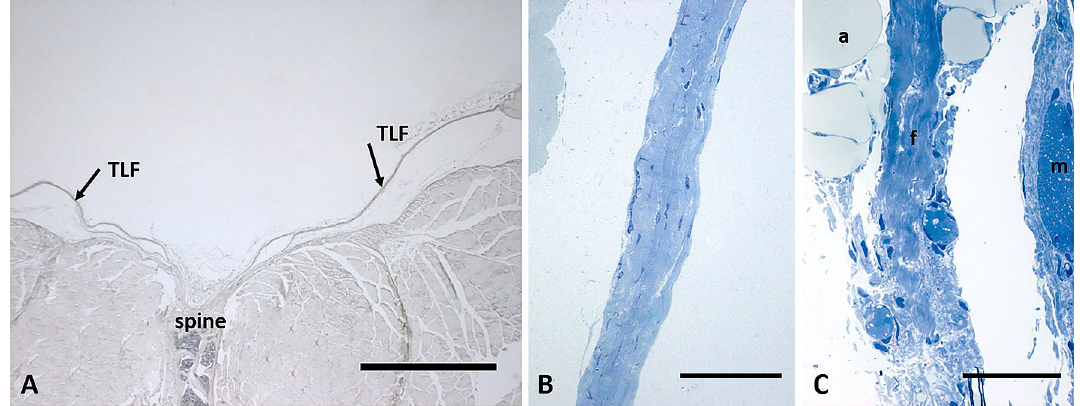
Figure 1. Thickness of thoracolumbar and gluteal fascia: ( A ) 5 µm section of fascia, spine and muscle, stained with ematoxylin and eosin; arrows indicate the thoracolumbar fascia (TLF); scale bar: 1000 µm; ( B ) 0.5 µm semithin section of thoracolumbar fascia stained with Toluidine Blue; scale bar: 50 µm; ( C ) 0.5 µm semithin section of gluteal fascia stained with Toluidine Blue; a: adipocytes; f: gluteal fascia; m: muscle; scale bar: 50